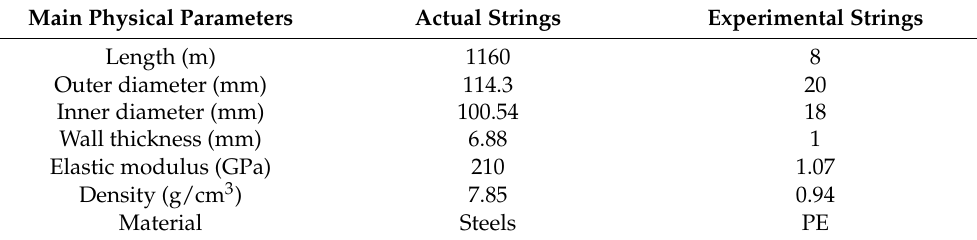
Figure 4. Physical map of the experimental device. ( a ) Outer leaching tubing; ( b ) experimental device for reverse circulation. Table 3. Main physical parameters of the experimental string